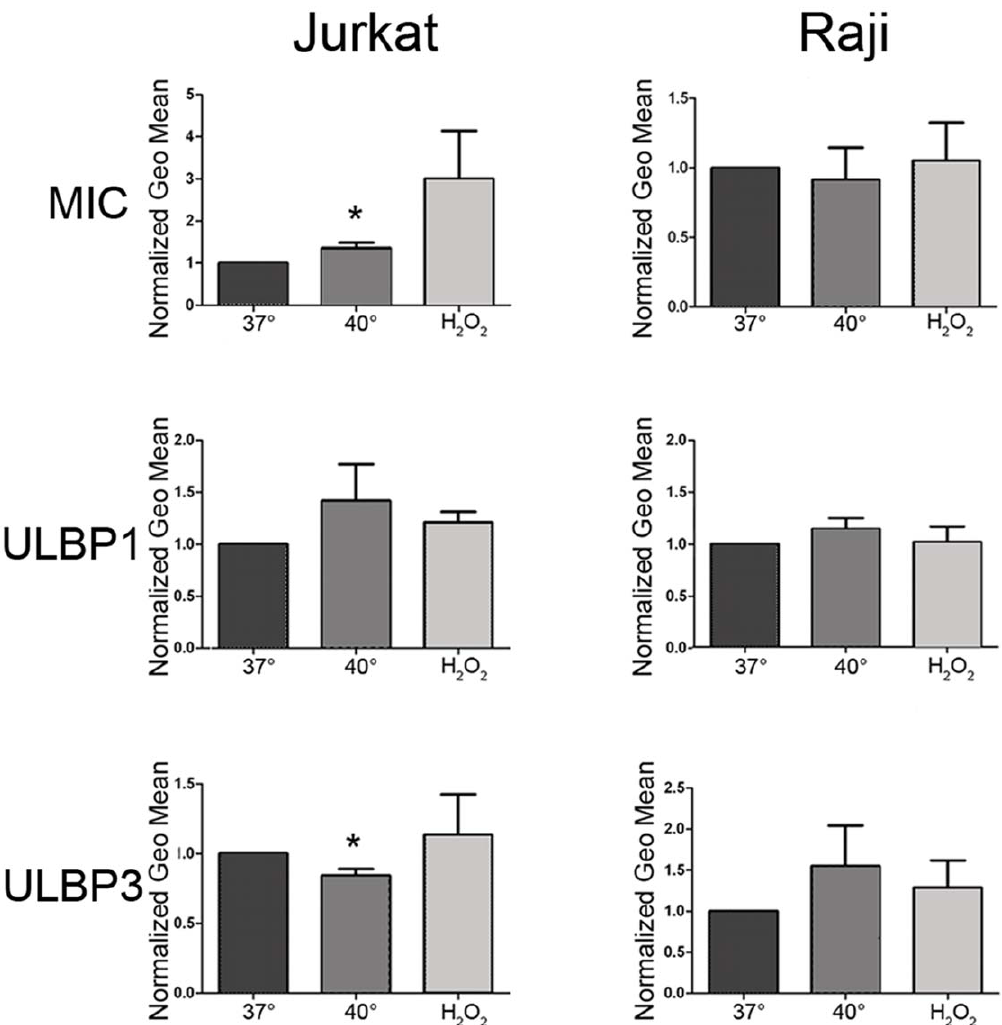
Figure 4. Stress-increased exosomal NKG2DL enhance the suppressive effect of Jurkat and Raji exosomes on NK-cell cytotoxicity. Immunoflow cytometry of latex microbead-captured exosomes released from unstressed and stressed cells stained for NKG2D ligands or the exosomal marker CD63. Geo mean of fluorescence intensity is normalized to steady state culture conditions at 37 u C (=1). *=statistical significance, p , 0.05.